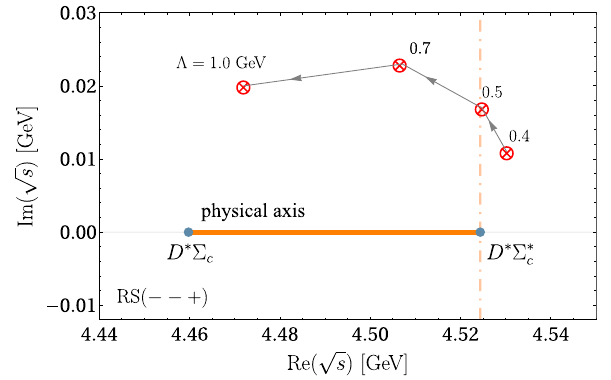
Fig. 4 ThepoletrajectoryonthesheetRS ( −−+ ) ofthe S -wave D (cid:2) ∗ c - D ∗ (cid:2) c - D ∗ (cid:2) ∗ c coupled-channel system with ( I , J ) = ( 1 / 2 , 3 / 2 ) . The cutoff (cid:4) is varied from 0.4 to 1.0GeV. The highest threshold is repre- sented by the orange dash-dotted line. The pole positions are denoted as theredcrosses. The sheetRS ( −−+ ) intersectswiththephysical region at the thick orange line that connects the D ∗ (cid:2) c and D ∗ (cid:2) ∗ c thresholds